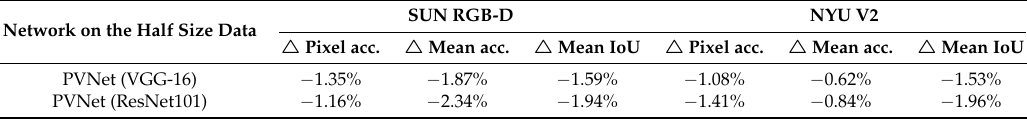
Table 6. The declining performance of Poxel-Voxel Net (PVNet) using half-sized data. (cid:52) represents the declining performance (in percentage) with half-sized data compared to that with full-sized